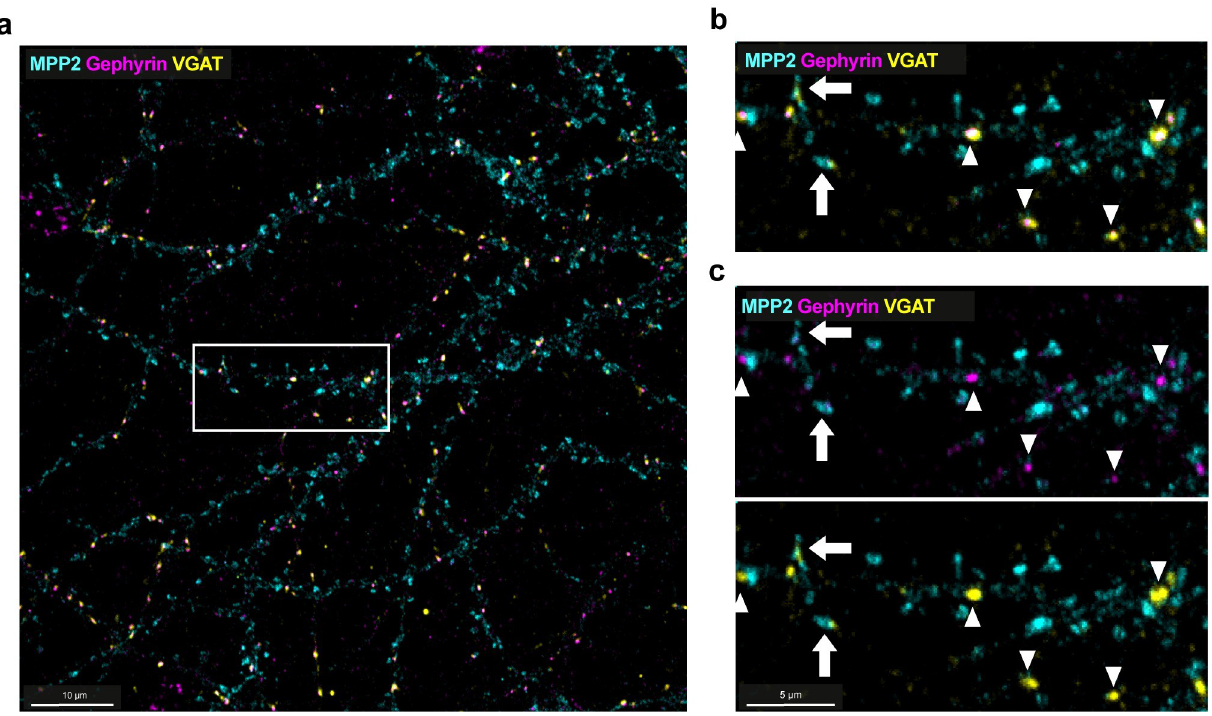
Fig 6. MPP2 is not expressed at classical inhibitory synapses. (a) Confocal imaging maximum projection of primary rat hippocampal neurons fixed at DIV21 and stained for endogenous proteins MPP2 (cyan) together with the inhibitory postsynaptic scaffold protein Gephyrin (magenta) and the inhibitory presynaptic marker VGAT (yellow). White box indicates region of detail view in b and c. Scale bar: 10 μ m. (b, c) Detail view of region indicated in a. MPP2 is clearly enriched in dendritic spines along neuronal dendrites (which have lower MPP2 expression) and generally distinct from inhibitory synapses (arrowheads) as marked by Gephyrin staining with directly adjacent VGAT. MPP2 and Gephyrin staining does not significantly overlap, but occasionally MPP2-positive spines have adjacent VGAT puncta (arrows). Scale bar: 5 μ m. DIV, days in vitro; MPP2, membrane protein palmitoylated